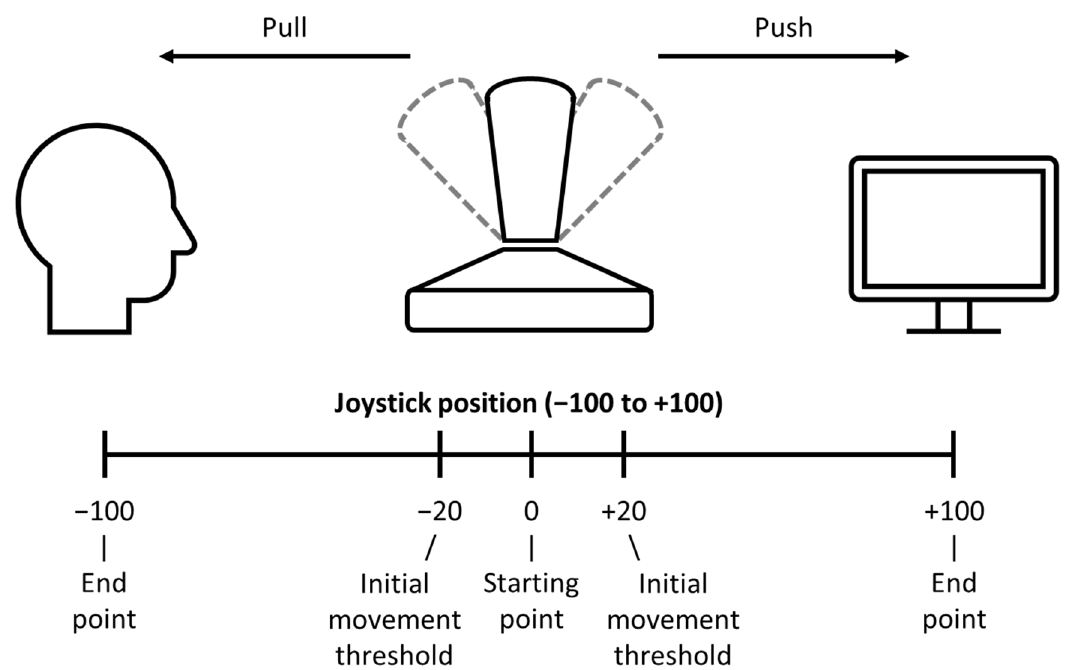
Figure 2. For a trial to begin, the joystick needed to be within ± 2% of the starting point. Participants were instructed to slightly pivot the joystick so that it was positioned within the starting range if the trial does not begin. Once the task display appeared, participants had to either push the joystick away from them (i.e., towards the screen) or pull the joystick towards them (i.e., away from the screen). The joystick was deemed to have been moved when it had passed the initial movement threshold (20% of the entire range in each direction). Start RT is the time between the task display onset and the initial joystick movement. End RT is the time between the task display onset and the completion of the movement. Responses were registered when participants completed the movement, that is, when the joystick reached either one of the two end points.